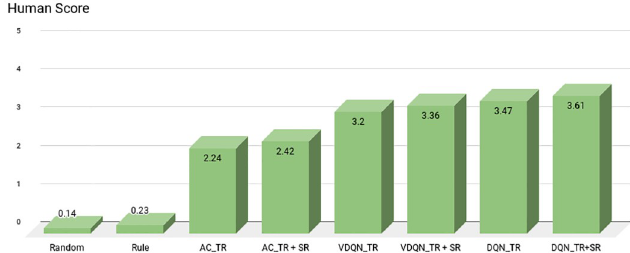
Fig 10. Human score for different baselines and proposed model.